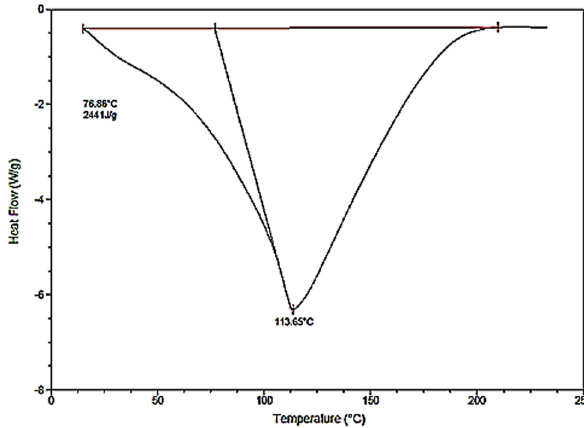
Figure 7: DSC - TGA of Ag - NPs.